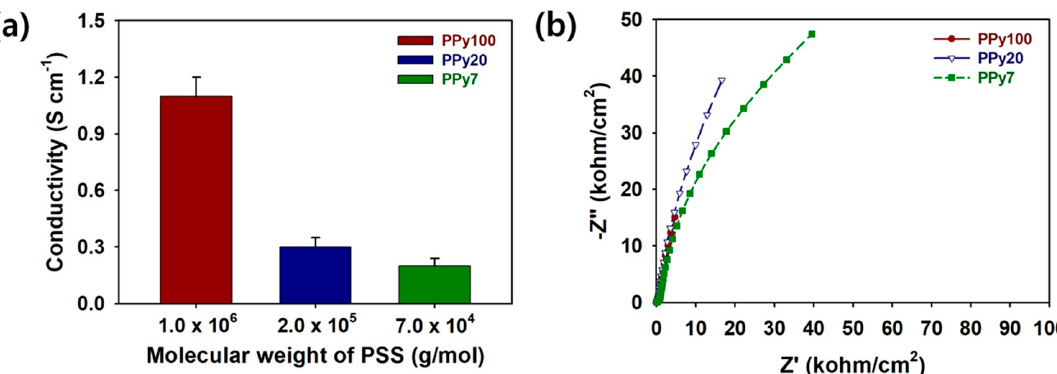
Figure 4. ( a ) The electrical conductivity of Polypyrrole:Poly(4-styrenesulfonate) (PPy:PSS) with different average molecular weights of 1.0 × 10 6 g/mol (PPy100), 2.0 × 10 5 g/mol (PPy20), and 7.0 × 10 4 g/mol (PPy7). ( b ) Nyquist impedance plots of the coin cells containing PPy:PSS with different average molecular weights of PPy100, PPy20, and PPy7 in the frequency range from 1 to 10 MHz.